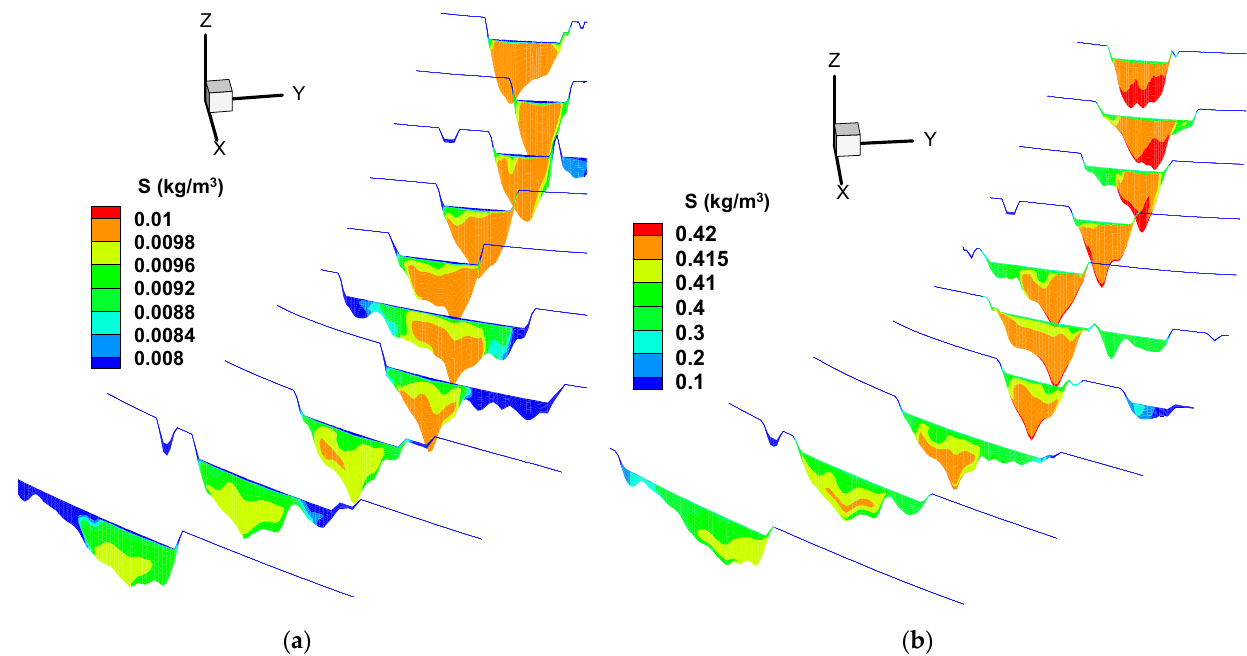
Figure 7. Calculated velocity fields near the bottom and the water surface (the blue lines are the velocity vectors close to the water surface, and the black lines are the vectors close to the bottom).